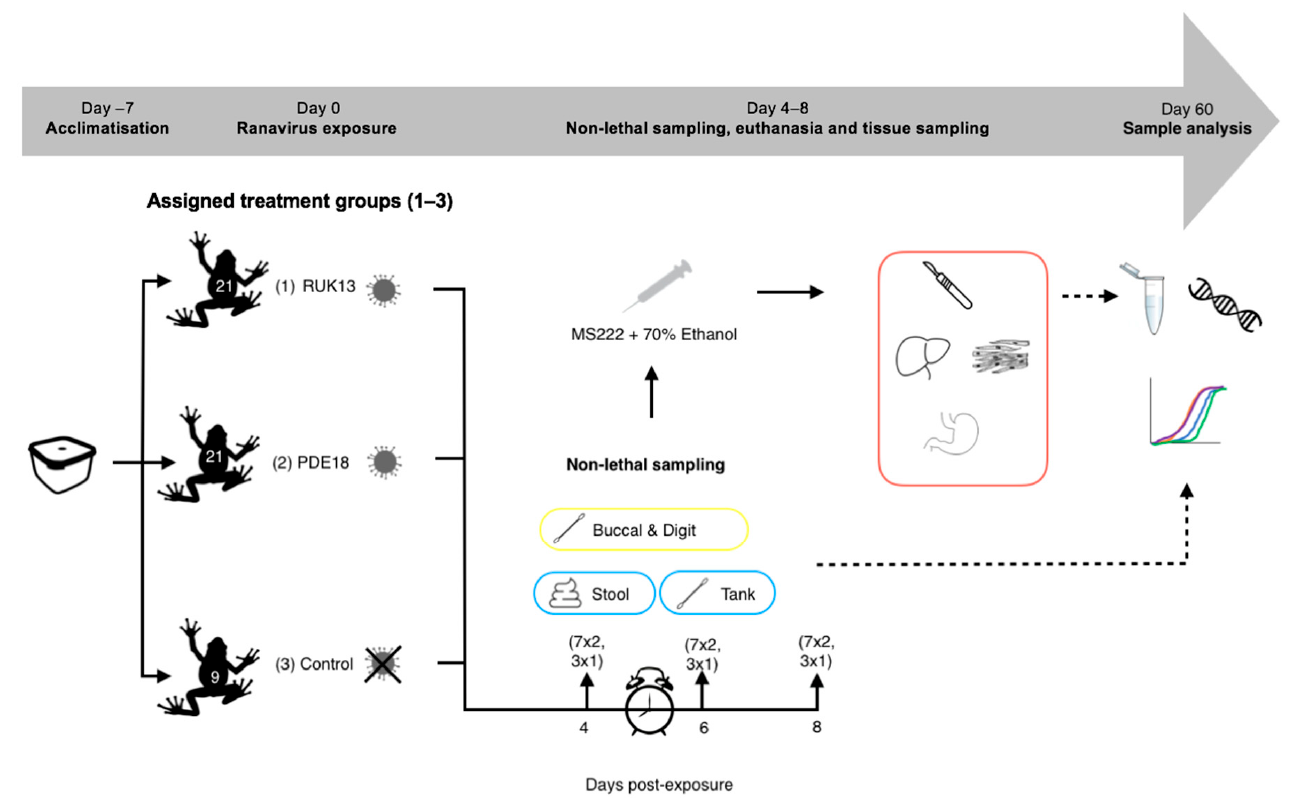
Figure 3. Experimental 2 workflow (experimental design and post-experimental processing).